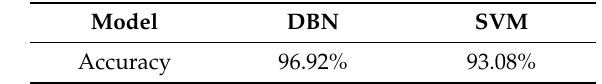
Table 4. Comparison of the recognition accuracy results between the DBN and support vector machine